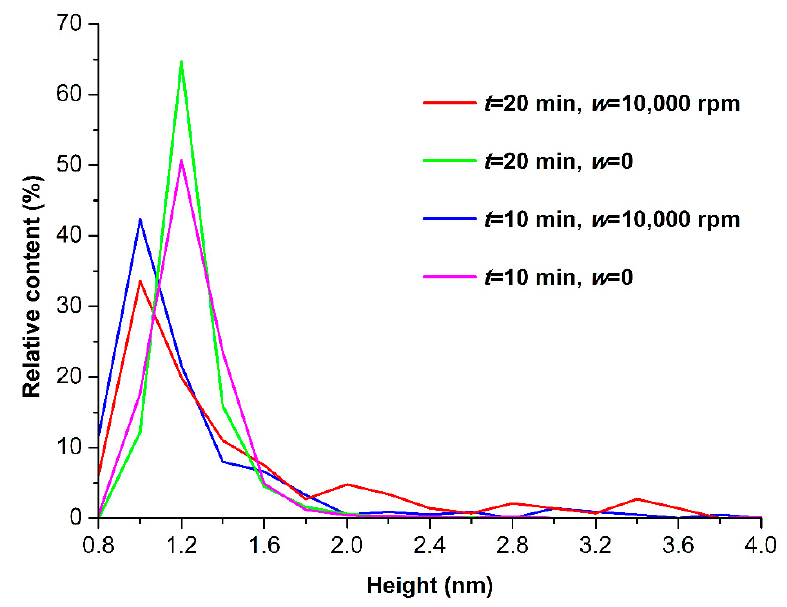
Figure 3. Relative distributions of the mica-adsorbed HRP particles with height ρ ( h ) obtained for the HRP samples incubated at 2 cm from the cone. Experimental conditions: w = 0 (non-rotating cone), t = 10 min (control) (magenta); w = 10,000 rpm (rotating cone), t = 10 min (working experiment) (blue); w = 0 (non-rotating cone), t = 20 min (control) (green); w = 10,000 rpm (rotating cone), t = 20 min (working experiment) (red).